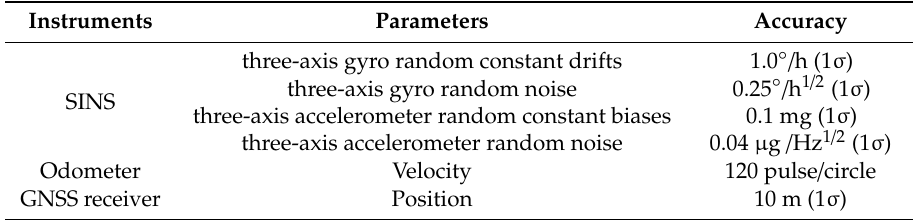
Figure 5. The real picture of the odometer. Table 1. Specifications of the instruments in the integrated navigation